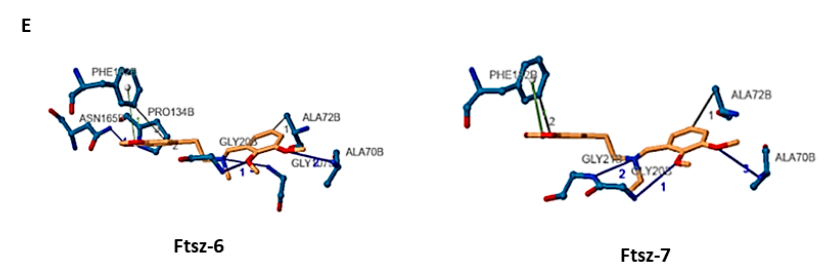
Figure 4. π -Stacking interaction of the benzodioxole ring of compounds 6 and 7 with Phe182 (see the text for details).